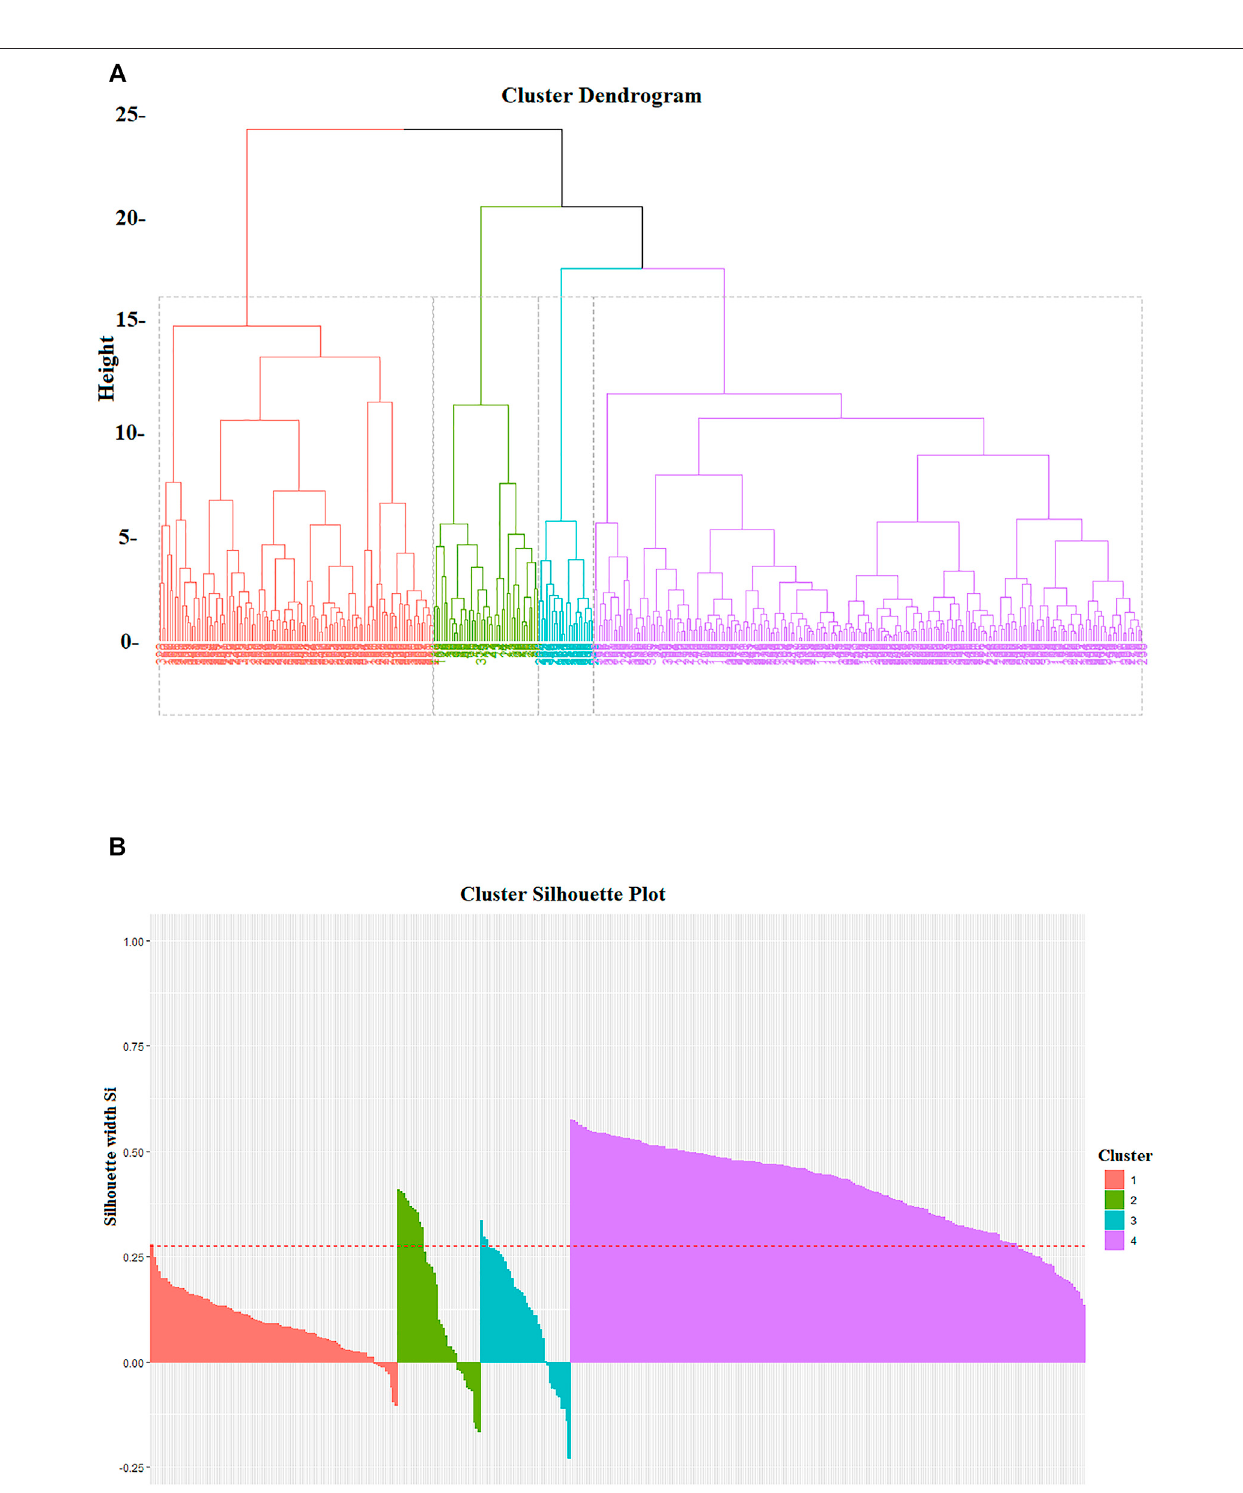
FIGURE 4 | (A) Cluster Dendrogram showing the different clusters obtained through k-means clustering. (B) Cluster silhouette plot showing the separation distance between the resulting four clusters. (C) Cluster plot denoting the identi fi ed clusters and farm households.